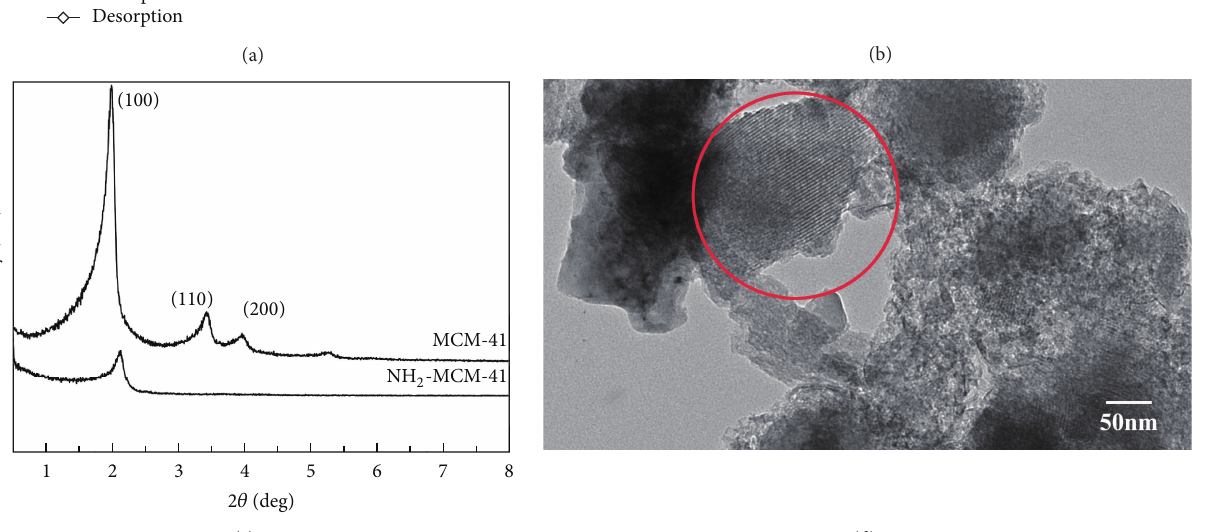
Cr(VI) reached electron from the –NH 3+ . By sharing a pair of electrons they formed a kind of coordinate bond. But in this research the second mechanism was the